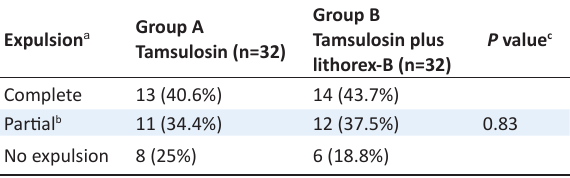
Table 2. Comparison the stone expulsion rate in two groups